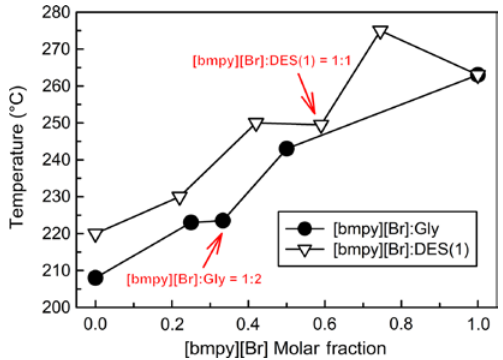
Figure 4: The 10% weight loss temperature obtained from the TGA for BDES and TDES versus [bmpy][Br] molar fraction. Error bars are smaller than the data points in the